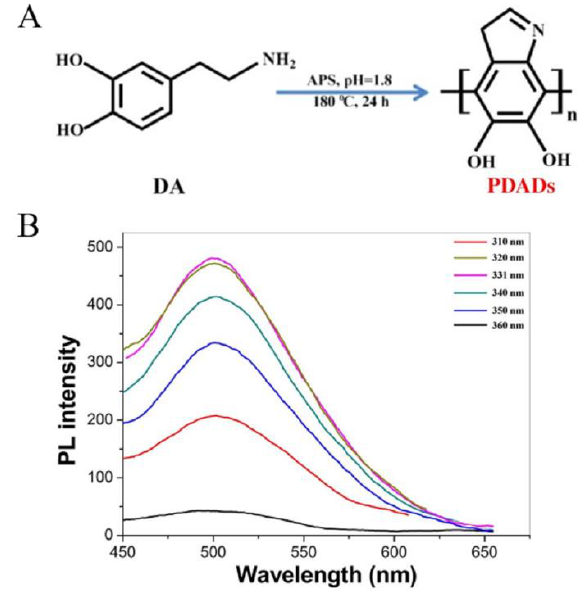
Figure 3. ( A ) Schematic of the preparation of PDAs. ( B ) PL spectra [52]. Reprinted/adapted with permission from Ref. [52]. 2017, Wiley-VCH.